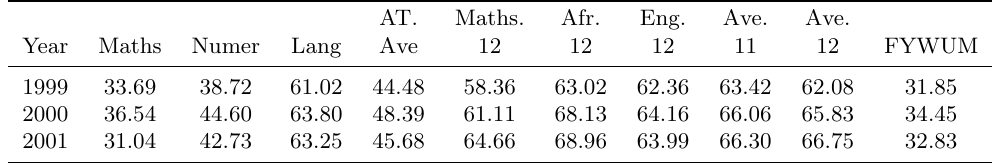
Table 5: Means of the variables of the Test Battery 2 data set for the 1999, 2000 and 2001 intake groups.